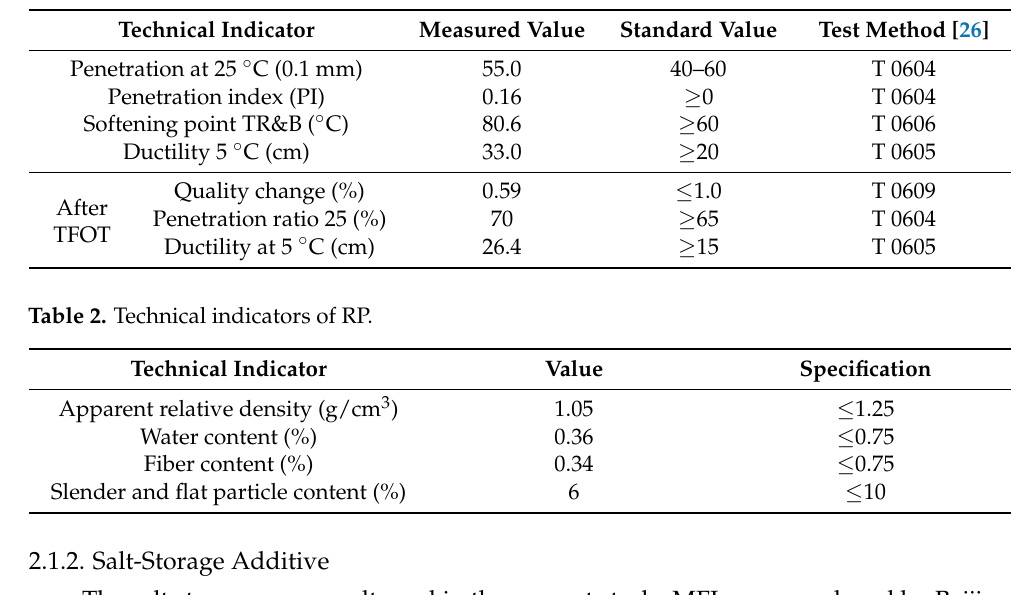
Table 1. Basic properties of SBS-modified asphalt.